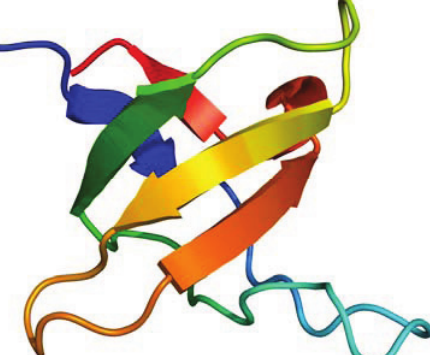
Figure 4. Structure of the N -terminal Src homology 3 domain (Protein Data Bank ID 1CKA). Beta sheets are represented by arrows and protein loops are shown as thin